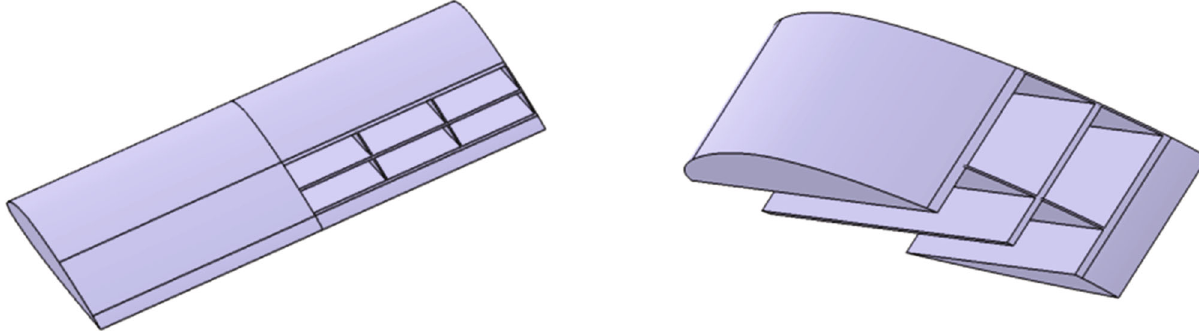
Figure 3: Schematic diagram of grid fusion lifting surface.